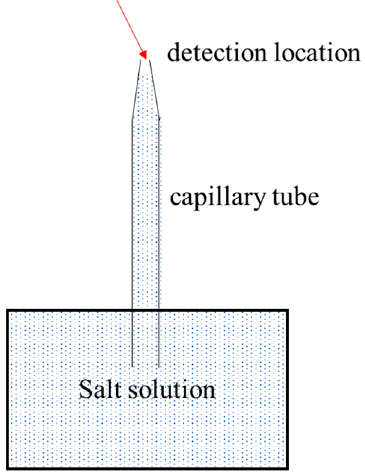
Figure 1. Sketch of migration and crystal morphology of solutions in capillary tubes.